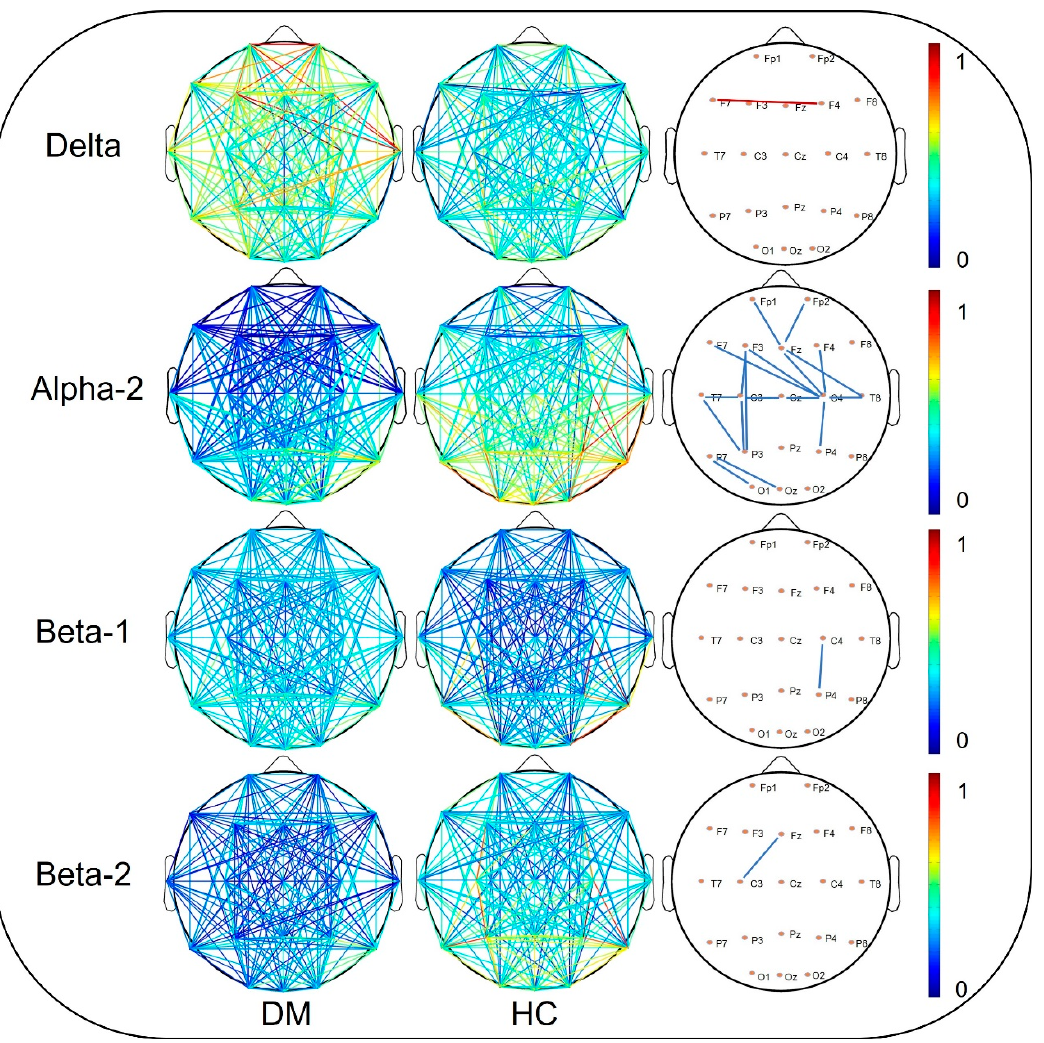
Figure 2. Brain network connectivity graphs of ScD and HC groups; on the right is the difference network diagram (red: ScD > HC; blue: ScD < HC); the strength of the connection between the nodes is indicated by the color of the line.